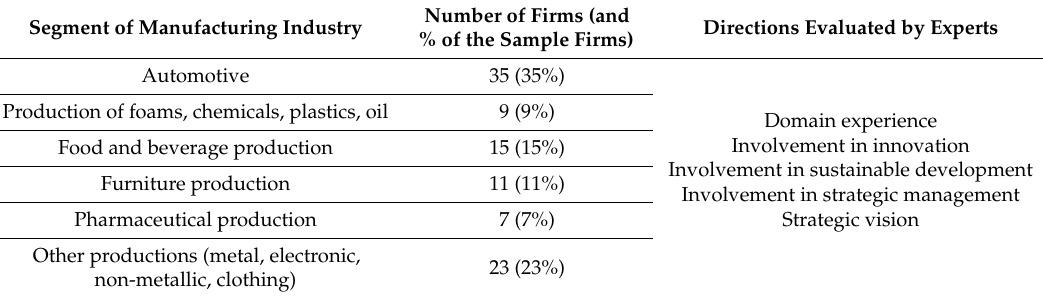
Table 2. Sustainable development and Industry 4.0.